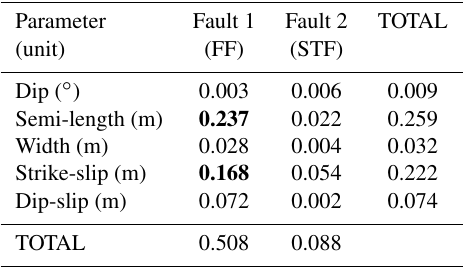
Table 3. Global sensitivity analysis. First-order Sobol’ coefficients for the fault parameters and total sums. Bold numbers represent the paramenters to which the data are predominally